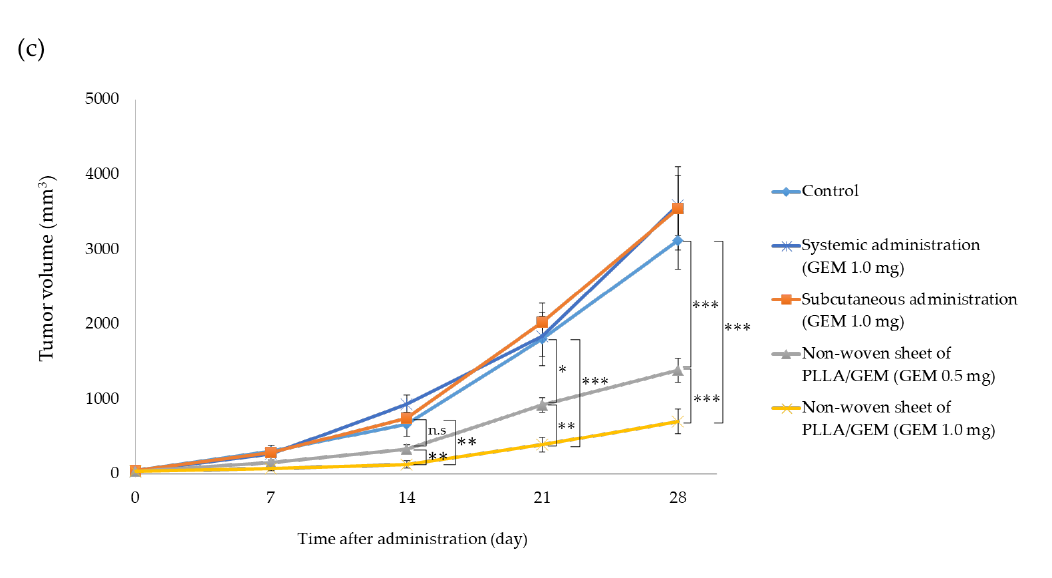
Figure 4. In vivo antitumor effects of the GEM-containing non-woven sheets. ( a ) GEM tissue concentrations. GEM concentrations in surrounding tissues following the implantation of the non-woven sheets in mice were measured at each time point. GEM concentrations released from the GEM-containing PLLA sheets at 1 h, 4 h, 1 d, 2 d, and 7 d were 89.6 ± 13.4, 21.5 ± 12.3, 1.1 ± 0.3, 1.3 ± 0.6, and 2.4 ± 0.8 μg/mL, respectively. In contrast, GEM concentrations released from the GEM-free PLLA sheets con taining the GEM solution at 1 and 4 h were 132.4 ± 54.3 and 2.3 ± 0.8 μg/mL, respectively, but GEM was not detected after 1 d. ( b ) Diagram showing the transplantation process. Tumors were implanted intradermally, and non-woven sheets were implanted subcutaneously. GEM-free non-woven sheets were injected with GEM at the time of implantation. ( c ) Antitumor effects of the GEM-containing non-woven sheets. Mice were subcutaneously inoculated with Panc02 cells, and changes in tumor size were measured over time. Control group: Tumor size on days 0, 7, 14, 21, and 28 was 40.3 ± 12.1, 301.9 ± 78.2, 664.8 ± 157.4, 1801.2 ± 353.7, and 3118.3 ± 384.9 mm 3 , respectively (n = 6). Systemic administration group: Tumor size on days 0, 7, 14, 21, and 28 was 36.0 ± 2.3, 260.4 ± 16.7, 929.0 ± 121.2, 1835.3 ± 269.8, and 3588.9 ± 397.7 mm 3 , respectively (n = 4). Subcutaneous administration (GEM 1.0 mg) group: Tumor size on days 0, 7, 14, 21, and 28 was 38.0 ± 2.0, 283.5 ± 44.6, 744.4 ± 65.9, 2019.6 ± 257.3, and 3544.4 ± 556.9 mm 3 , respectively (n = 4). Non-woven PLLA/GEM (GEM 0.5 mg) sheet group: Tumor size on days 0, 7, 14, 21, and 28 was 34.9 ± 9.7, 151.8 ± 34.7, 326.5 ± 62.1, 923.0 ± 96.8, and 1384.5 ± 158.4 mm 3 , respectively (n = 4). Non-PLLA/GEM (GEM 1.0 mg) woven sheet group: Tumor size on days 0, 7, 14, 21, and 28 was 31.4 ± 7.6, 68.9 ± 24.0, 125.0 ± 45.5, 388.9 ± 98.6, and 702.2 ± 163.9 mm 3 , respectively (n = 7). Results are presented as the mean ± SEM. Significant differences were determined using Student’s t -test (* p < 0.05, ** p < 0.001, *** p < 0.005, n.s: Not significant).